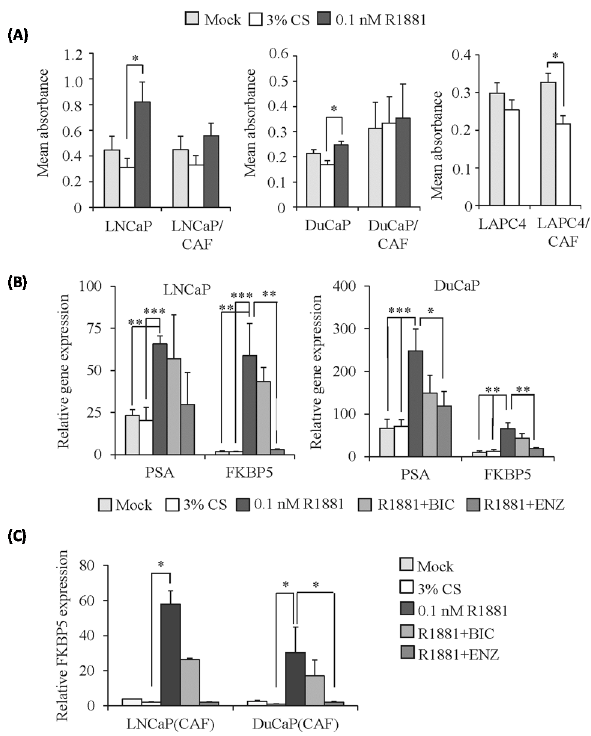
Figure 5. Androgen responsiveness of PCa monoculture and PCa/CAF co-culture spheroids. 3D spheroids were cultured in androgen-deprived medium containing 3% charcoal-stripped FCS (3% CS) with or without 0.1 nM R1881 and/or the anti-androgens bicalutamide (BIC) and enzalutamide (ENZ) to a final concentration of 5 µ M. ( A ) Cell viability was assessed by WST-1 assay after 10 days of treatment and expressed as mean absorbance relative to vehicle control (mock) where spheroids were cultured in standard medium (10% FCS + 0.1% DMSO); ( B ) qPCR of prostate specific antigen (PSA) and FK506 binding protein 5 (FKBP5). Target gene expression was normalized to GAPDH and HMBS and expressed as relative gene expression; ( C ) FKBP5 mRNA expression was determined in GFP negative FACS sorted PCa cells from LNCaP/CAF and DuCaP/CAF co-culture spheroids following eight days of 3D culture under the conditions indicated. Values denote mean gene expression relative to the mock control with SEM ( n = 2). * p < 0.05; ** p < 0.01; *** p < 0.001.